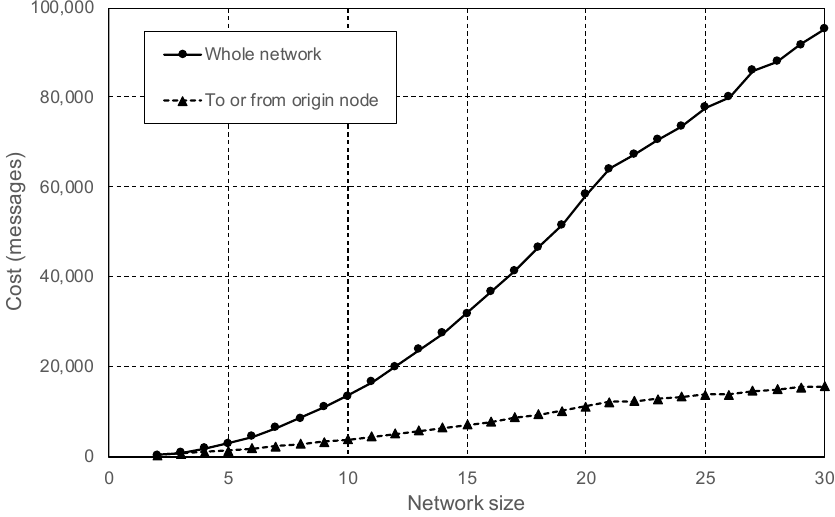
Figure 7. Total of messages exchanged in the peer network when content is